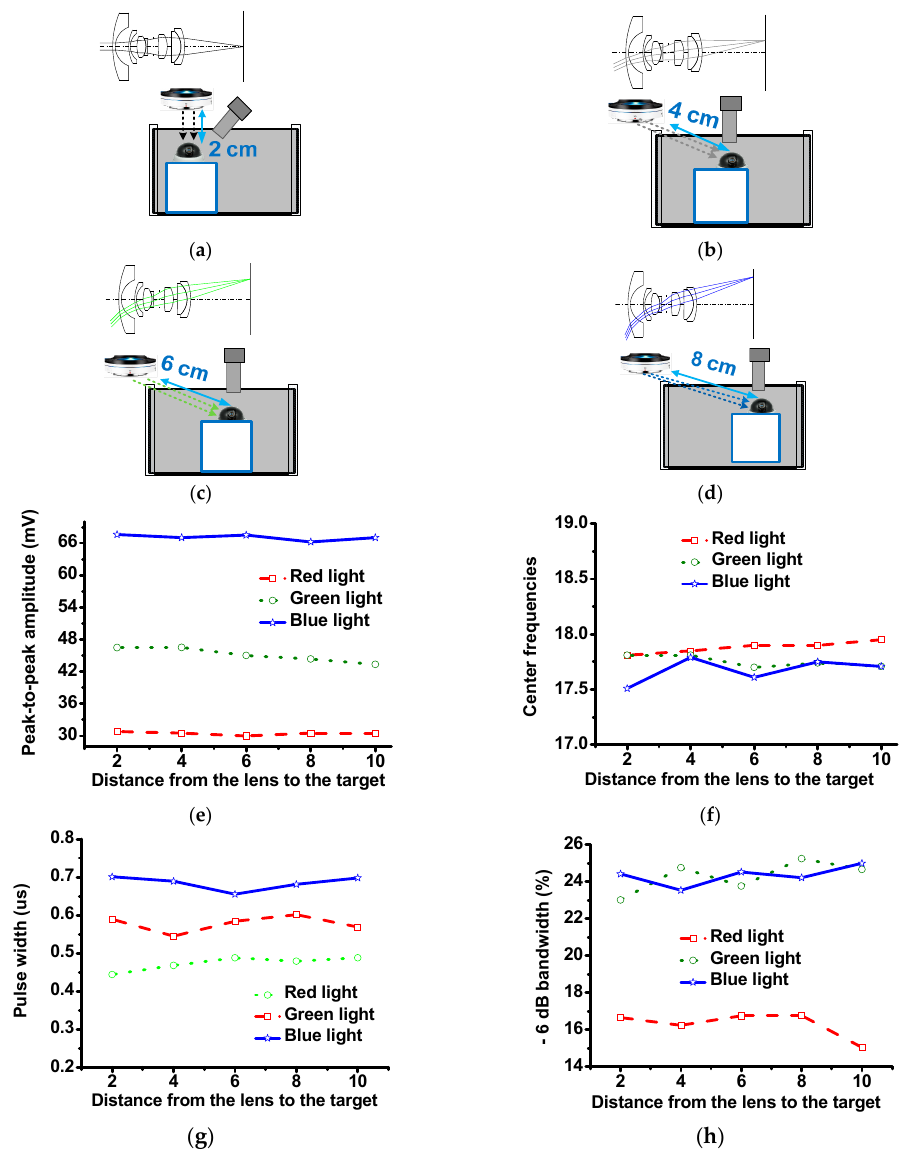
Figure 10. Configurations of the fisheye lens system and sample with the fisheye lens system ( a ) located 2 cm directly above the target and separated from the target diagonally by ( b ) 4 cm, ( c ) 6 cm, and ( d ) 8 cm. ( e ) Peak-to-peak echo amplitudes, ( f ) center frequencies, ( g ) pulse widths, and ( h ) − 6 dB bandwidths vs. distance from the lens to the target. The results obtained using the red, green, and blue lights are represented by the dashed-dotted, dotted, and solid curves, respectively. In Figure 10h, the − 6 dB bandwidths measured using red, green, and blue LED lights are 16.66%, 16.24%, 16.75%, 16.76%, and 15.04%; 23.01%, 24.76%, 23.77%, 25.25%, and 24.67%; and 24.42%, 23.54%, 24.53%, 24.22%, and 25%, respectively. These measured pulse widths and − 6 dB bandwidths also confirm that wide fields of view can be achieved using the fisheye lens system.